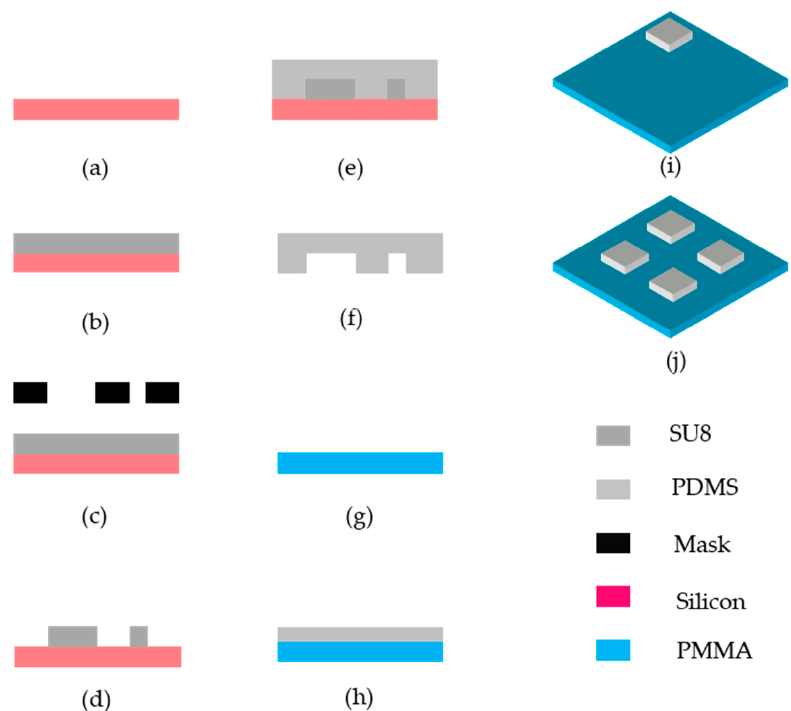
Figure 7. Soft lithography process flow of microfluidic metasurfaces working at GHz region. The control system and the microfluidic channels hosting the liquid metal droplets are fabricated using the same process. The large array of metamolecules is realized by multi-sample stitching technique.